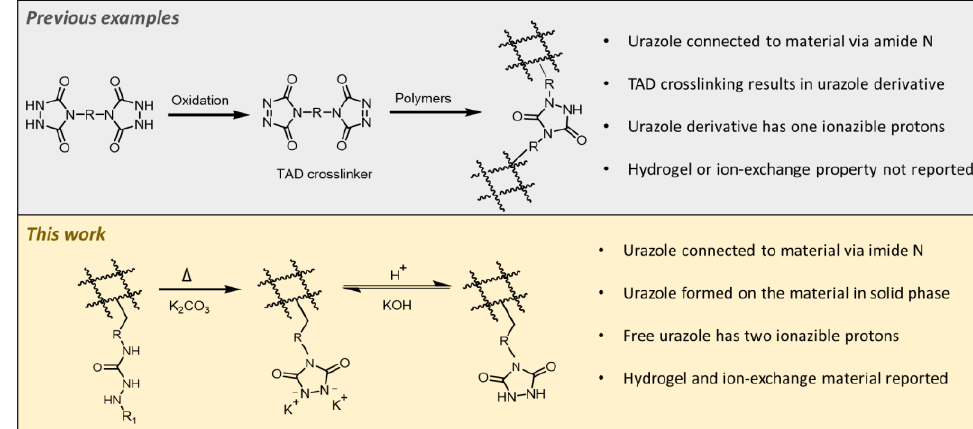
Figure 1. Comparison of urazole containing materials with the present